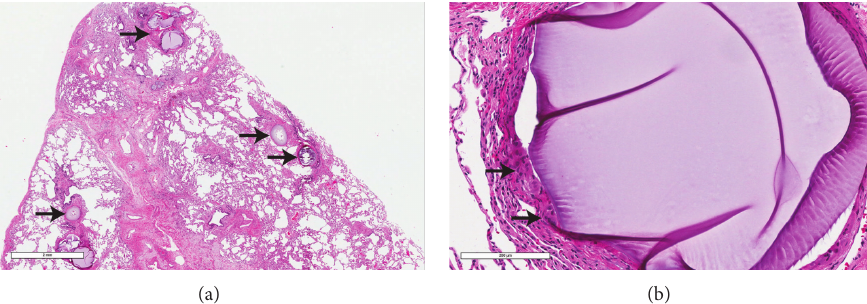
Figure 3: Trisacryl gelatin microemboli. (a) Microemboli (arrows) involving muscular pulmonary arteries (hematoxylin-eosin, original